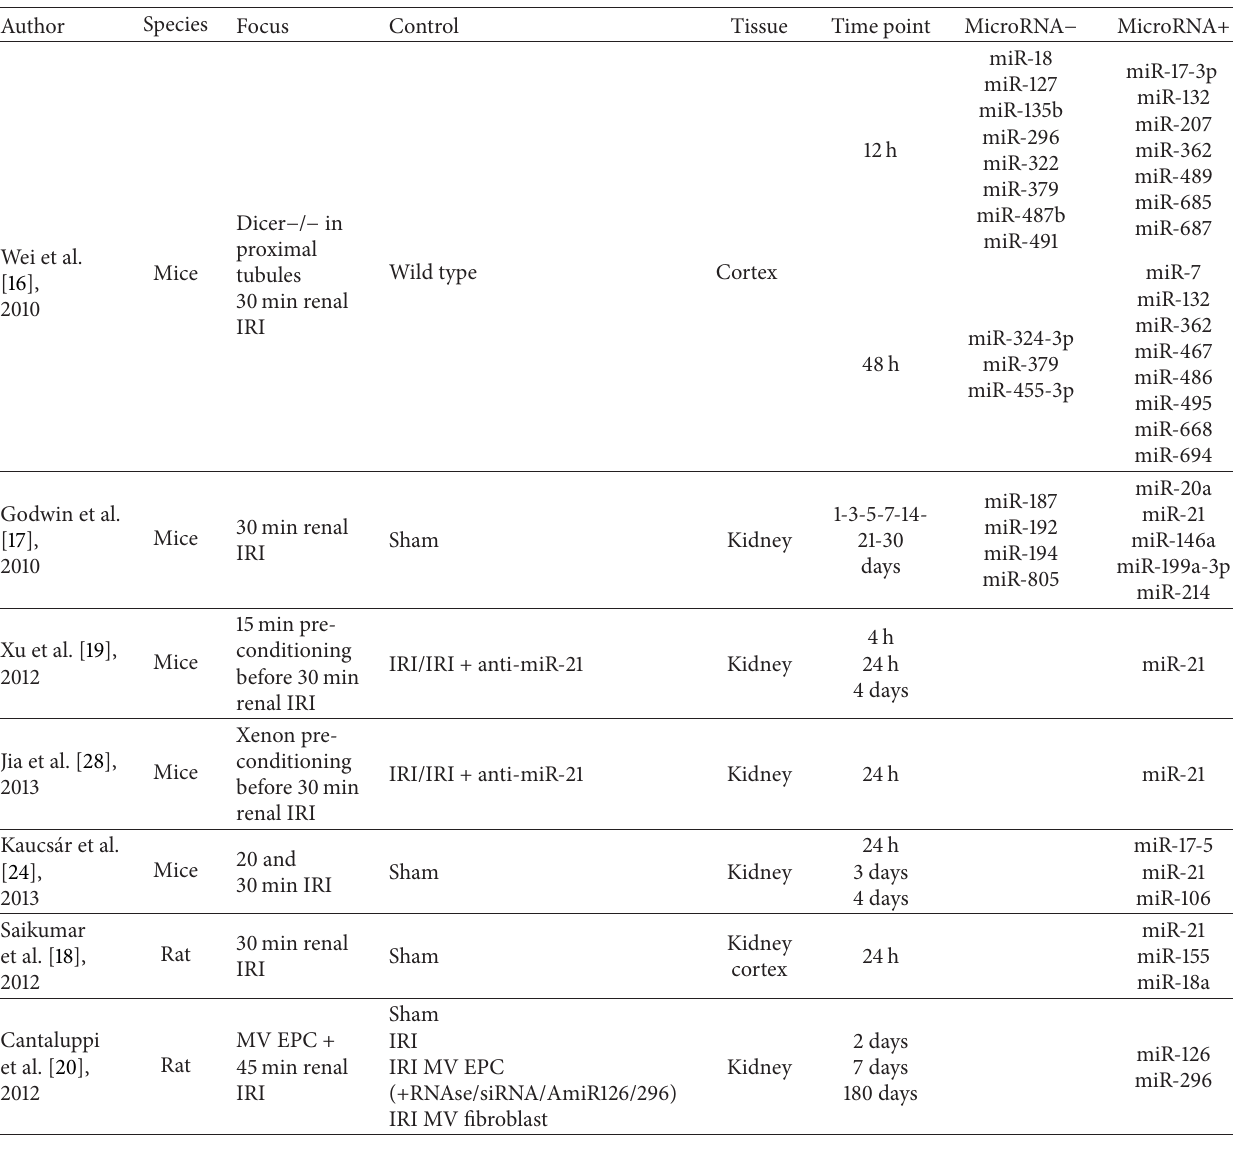
Table 1: Up- and downregulated miRNAs found in in vivo studies. miRNA − : downregulated miRNA, miRNA+: upregulated miRNA, MV: microvesicles, EPC: endothelial progenitor cells, and AmiR =